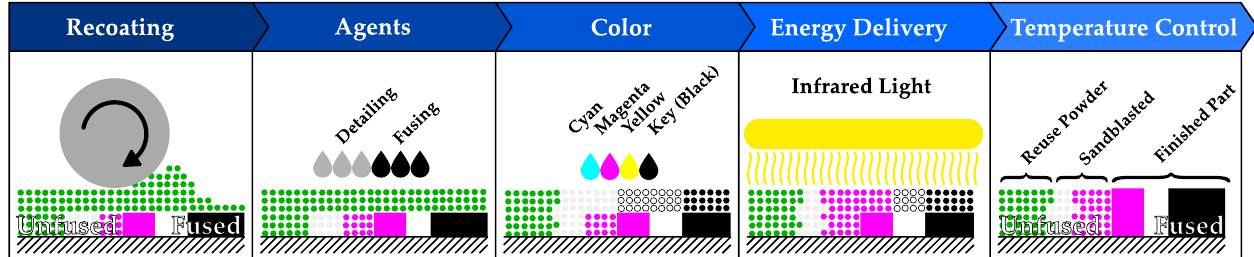
Figure 1. A scheme of the Multi Jet Fusion printing process for the HP Jet Fusion 580 Color 3D printer.